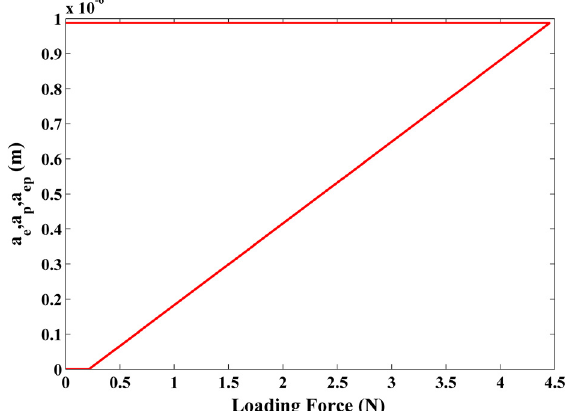
Table 2. The physical characteristics of aluminum used in the model